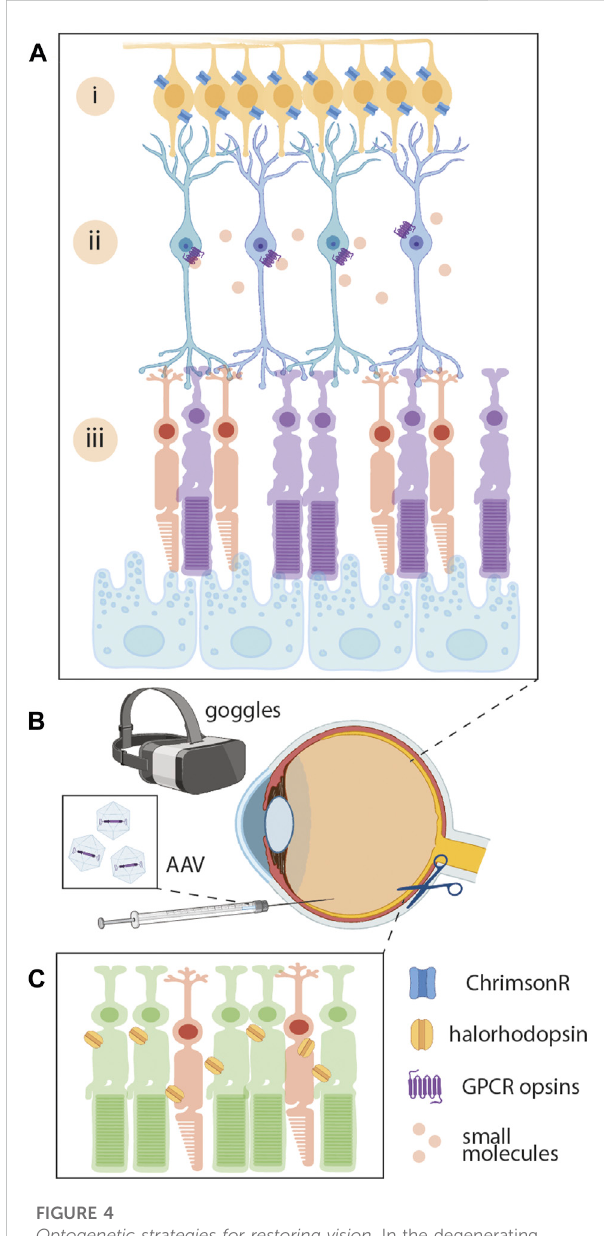
FIGURE 4 Optogenetic strategies for restoring vision. In the degenerating retina (A) , dying photoreceptors (iii) fail to detect light or provide the retinal interneurons with signals about visual input. Solutions include targeting retinal ganglion cells (i) with channelrhodopsins (such as ChrimsonR, blue ). Another option is to target bipolar cells (ii) with GPCR opsins ( purple ) or to combine this approach with small molecules ( red circles ) that further increase light sensitivity. (B) Administration of therapy requires intravitreal delivery of AAVs mediating opsin expression in the bipolar cells and retinal ganglion cells. Use of optogenetic goggles convert digital images from a camera into light stimulation of the treated retina to support patients ’ restoration of vision (C) Another possible solution is to replace dying photoreceptors with a graft of human iPSC-photoreceptors that have been transduced with optogenetic proteins like